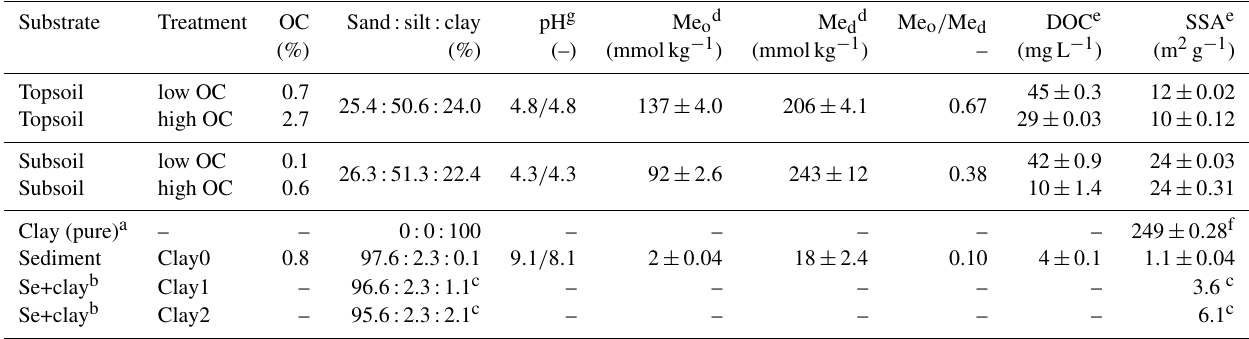
Table 2. Texture, pH values, OC and metal oxide contents (mean of three measurements), DOC concentrations (median of two measurements) and specific surface area (median of two measurements) of topsoil and subsoil and the sediment in dependence of the respective treatment (high or low OC). Treatments “high OC” are the untreated samples and “low OC” the H 2 O 2 -treated samples. Me o is the summed content of all oxalate extractable metal oxides (Fe o + Al o + Mn o ) and Me d is the summed content of all dithionite extractable metal oxides (Fe d + Al d + Mn d ).